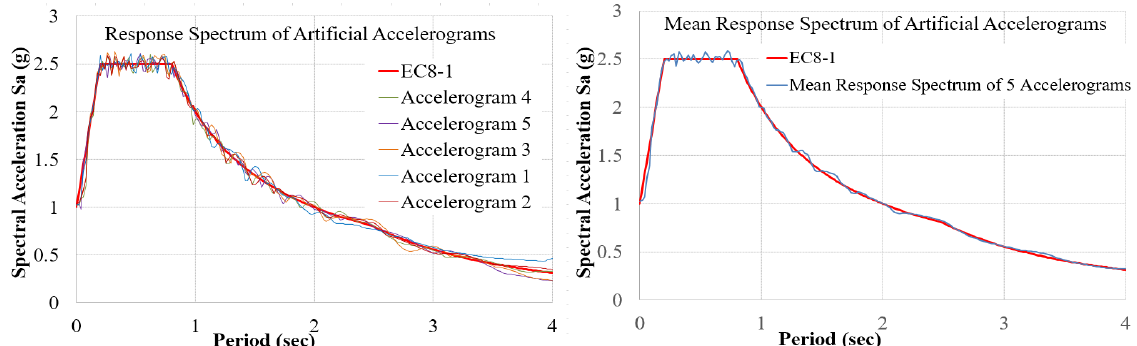
Fig. 7. Elastic acceleration spectra of the five accelerograms and their average elastic acceleration spectrum relative to the elastic design spectrum of EN 1998-1 (damping 0.05, a